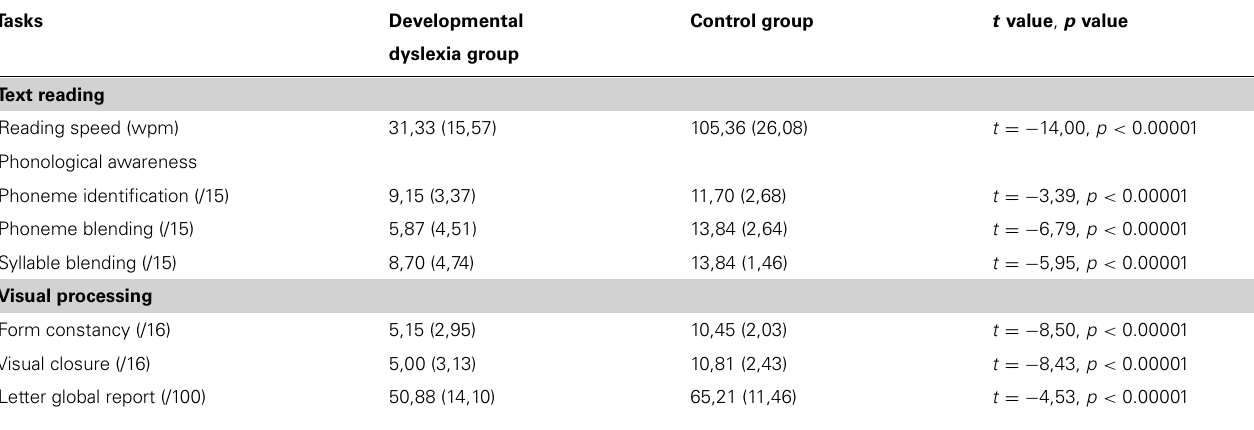
Table 2 | Mean scores (and SD) of the control and children with developmental dyslexia for text reading, phonological awareness and visual processing. Tasks